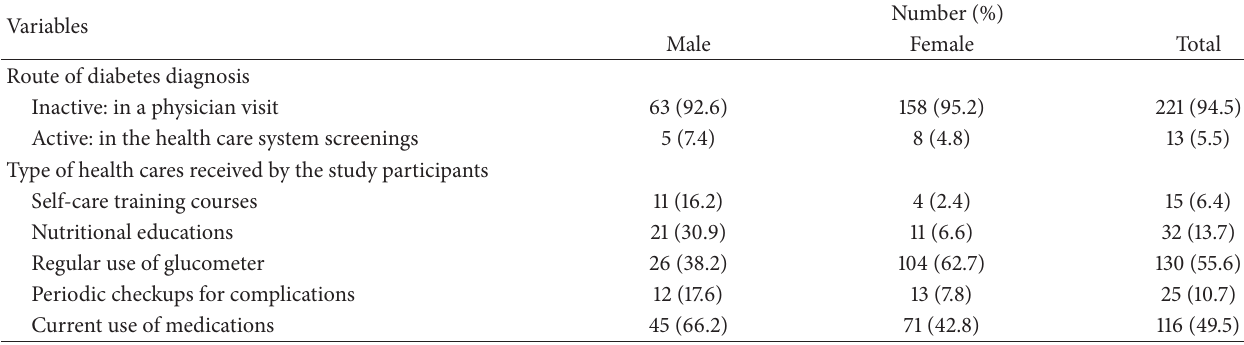
Table 2: Route of diagnosis and received health care amongst the studied type 2 diabetic patients.